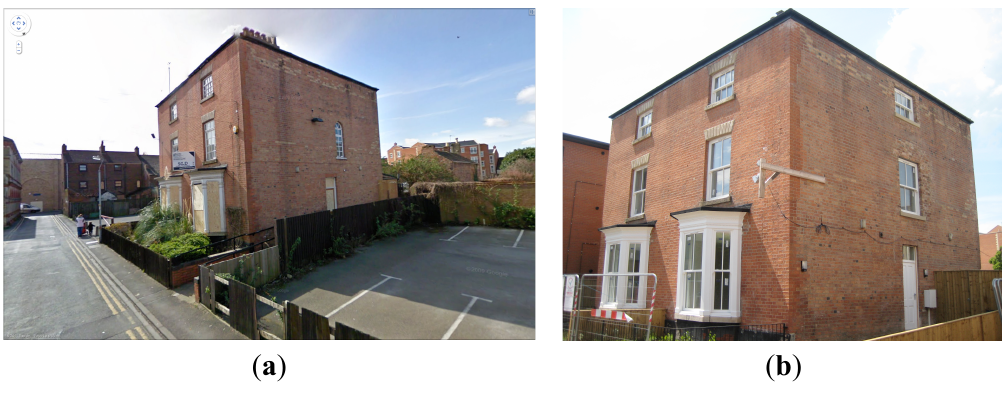
Figure 1. Cross Street Building ( a ) before; and ( b ) after refurbishment.